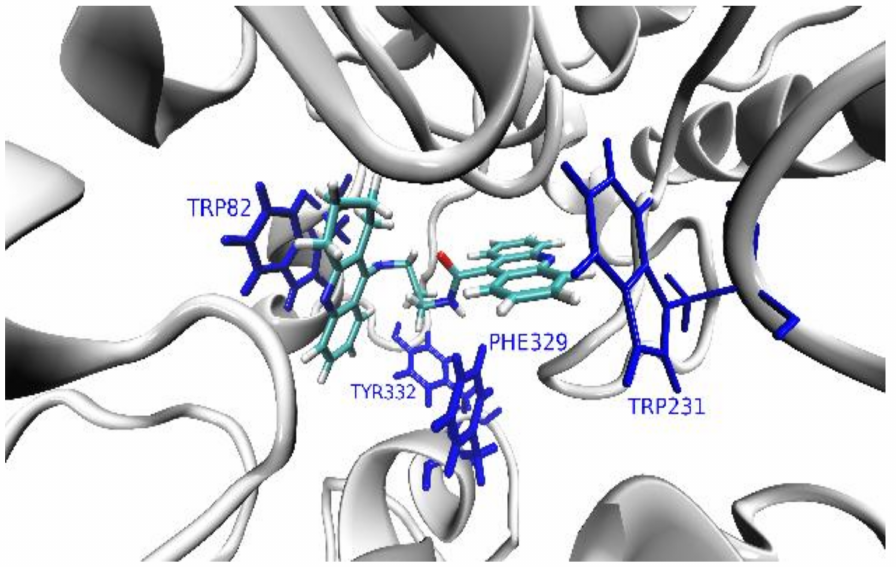
Figure 6. The binding mode of the 3b ligand inside the pocket of BuChE. The key ligand-binding aromatic residues in the pocket of BuChE are marked in